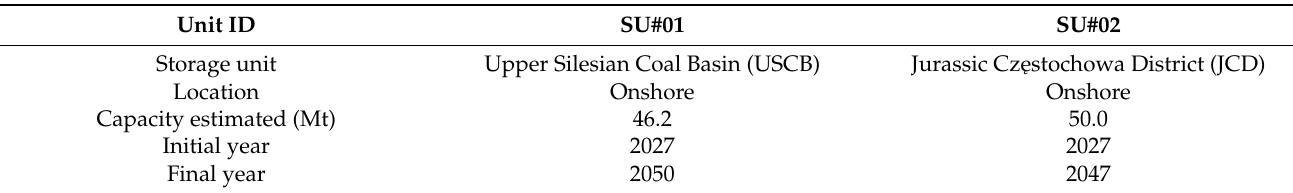
Table 3. Characteristics of DSAs considered in the baseline